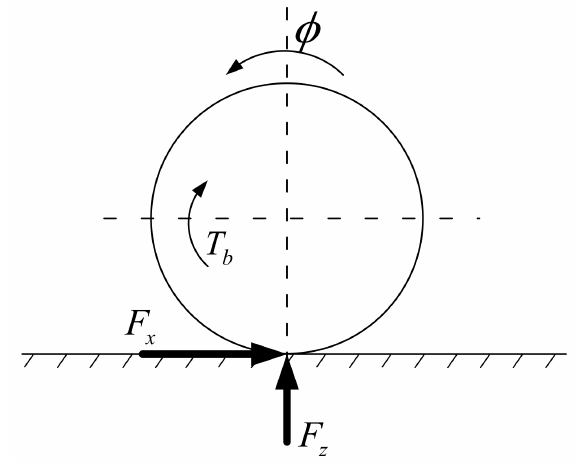
Figure 3. The vertical load on the